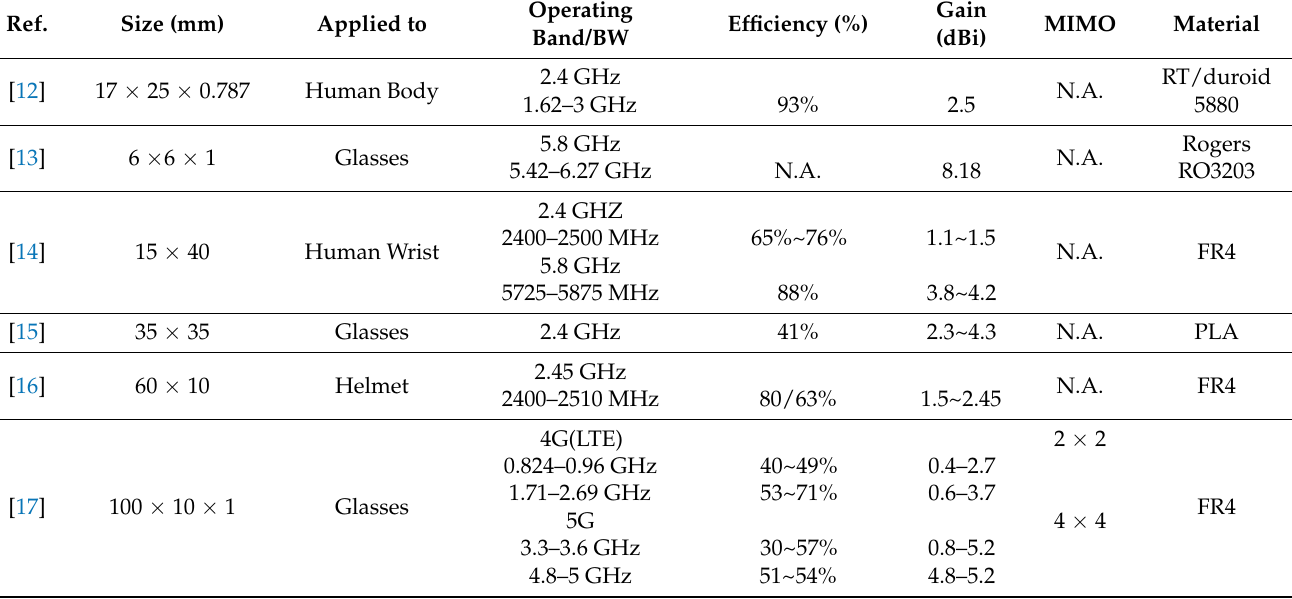
Table 3. Antenna Comparison